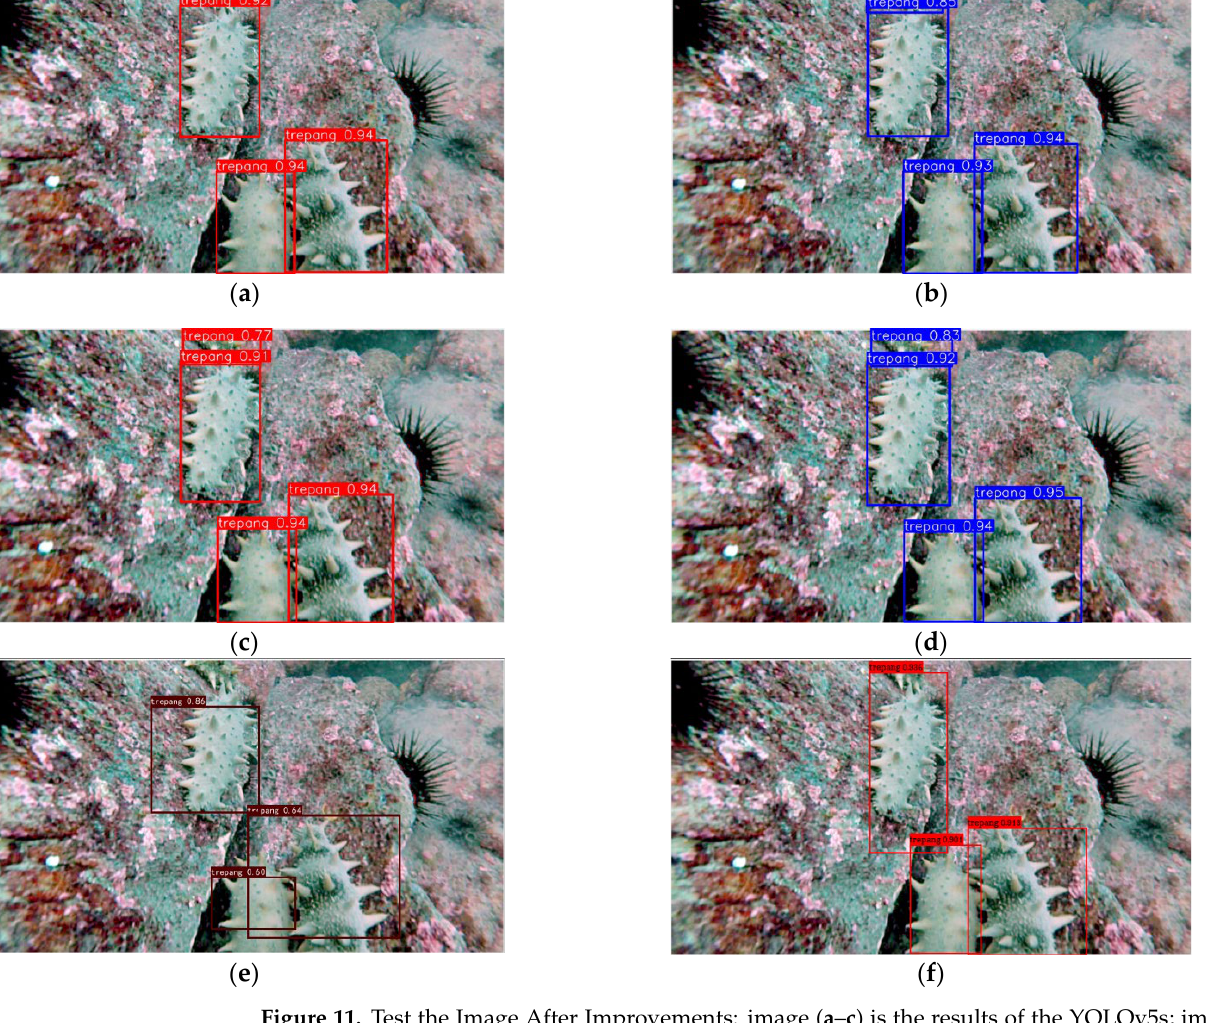
Figure 11. Test the Image After Improvements: image ( a – c ) is the results of the YOLOv5s; image ( b – d ) is the results of the improved YOLOv5s; image ( e ) is the result of YOLOv4; and image ( f ) is the result of Faster-RCNN.